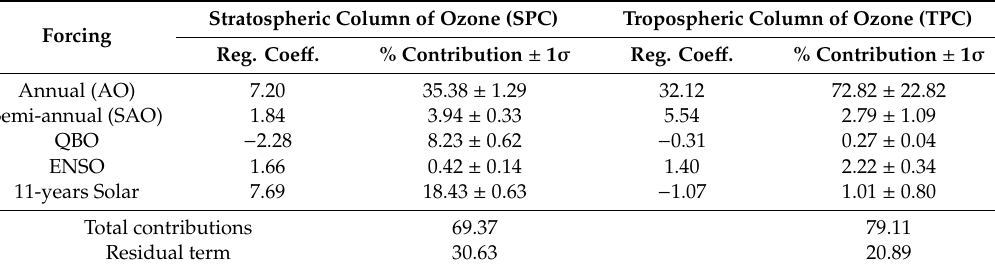
Table 2. Regression coefficients and percentage of contributions of forcings as derived from the Trend-Run model applied to tropospheric and stratospheric columns of ozone at Irene